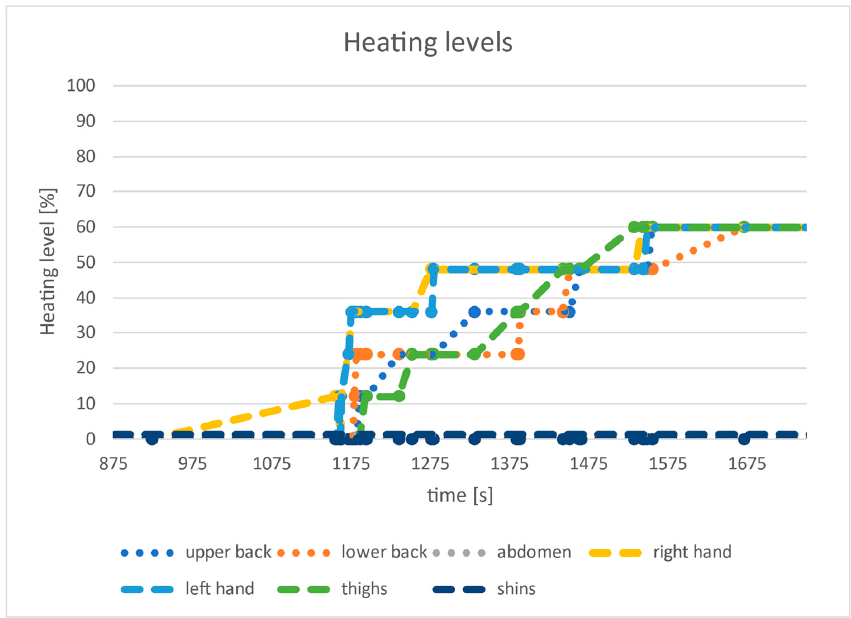
Figure 8. Heating levels for participant C when adjusting to reach subjective thermal comfort. The local skin temperature measurements are presented in Table 5. The presented values are for the moment when the participants reported reaching the state of thermal comfort.